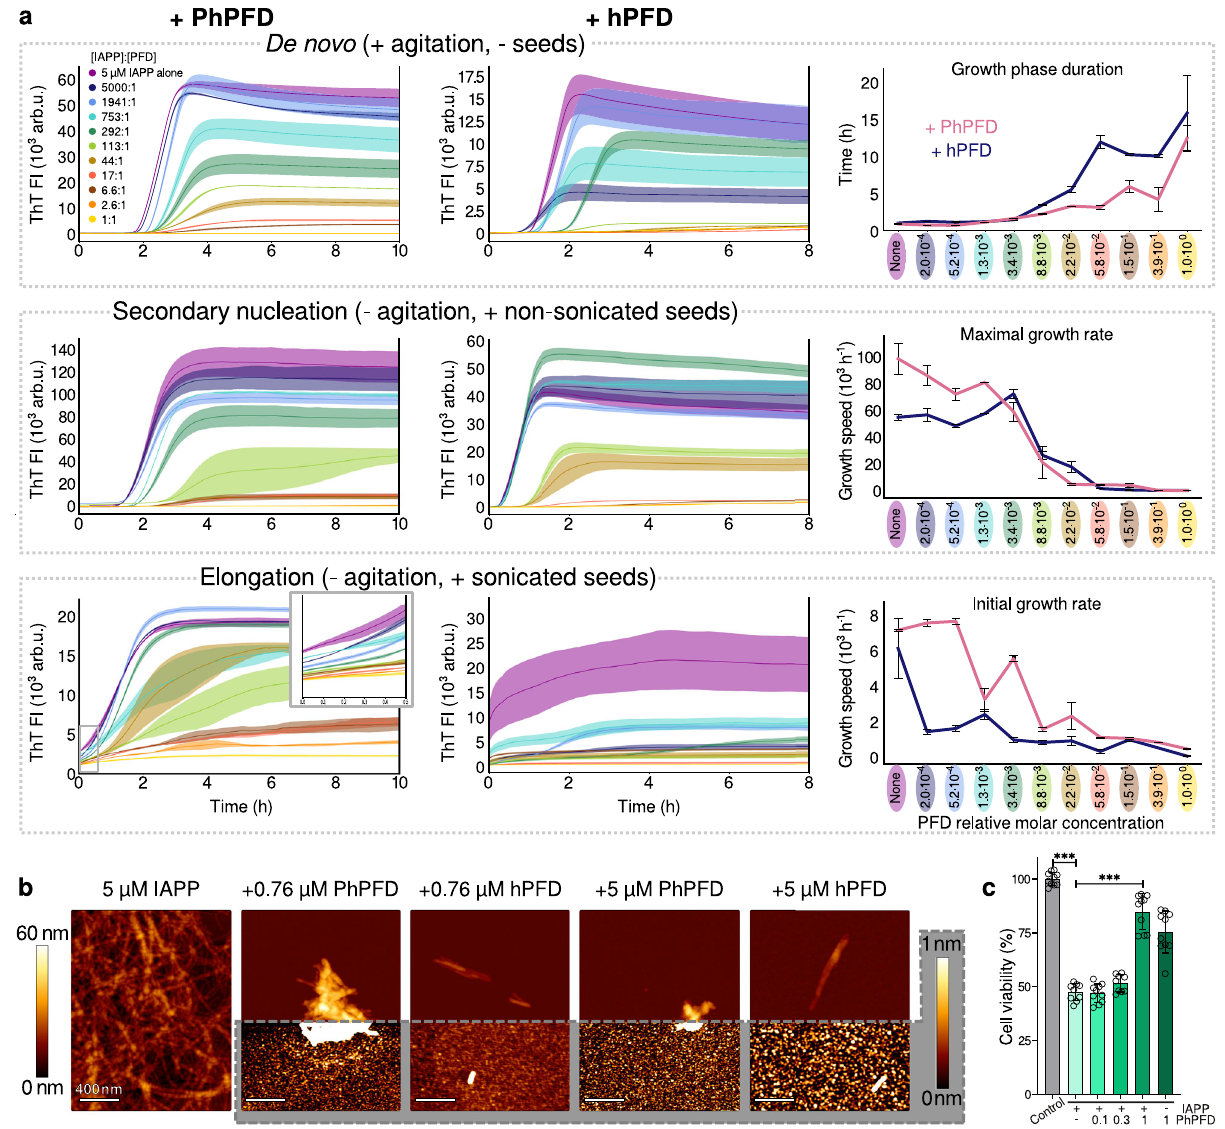
Fig. 1 Inhibition of IAPP aggregation by prefoldin. a IAPP (5 µ M) aggregation kinetics in absence and presence of PhPFD (left column) and hPFD (middle column) with [PFD]:[IAPP] molar ratios ranging from 1:5000 to 1:1, followed by ThT fl uorescence intensity (FI). Top row: de novo aggregation assay, starting from monomeric IAPP only, in presence of agitation. Middle row: secondary nucleation assay, starting from a mixture of monomeric IAPP and non- sonicated preformed IAPP fi brils (seeds), without agitation. Bottom row: elongation assay, showing non-agitated aggregation of monomeric IAPP in presence of shorter sonicated seeds, where the initial linear parts of the curves (inset) are re fl ecting pure elongation of fi bril seeds. The right column shows extracted kinetic parameters: growth phase duration, maximal growth rate, and initial growth rate. Further kinetic analysis is presented in Supplementary Fig. 1a. Every curve represents a mean of n = 3 replicates with the error shadows illustrating SD; the kinetic parameters are shown as mean ± SD. b AFM images of the samples at the end of the aggregation assays in section a (top row). Scale bar corresponds to 400 nm. In order to visualize objects decidedly differing in height, two color code scales were used: the gradient from dark brown to white represents either 0 – 60 nm height, or 0 – 1 nm (highlighted in gray). The full AFM overview is presented in Supplementary Fig. 2, including the control sample containing PFD alone and illustrating that the carpet-like coverage of the surface with small roundish particles at increased PFD concentration is the appearance of PFD itself. c PhPFD reduces the IAPP-induced negative impact on cell viability of RIN-m5F cells. After incubation of RIN-m5F cells with 1 µ M IAPP w/o or with several concentrations of PhPFD (0.1, 0.3, 1 µ M), an MTT cell viability test was conducted. Data is represented as mean ± SD (out of n = 2 independent experiments with four to fi ve technical replicates), one-way ANOVA with Tuckey post hoc analysis, *** p ≤ short, pre-formed IAPP fi brils to offer a high number of fi bril (see Arosio et al. for an overview of potential target species for ends (Fig. 1a, bottom row). Under these conditions, the very fi rst inhibition of speci fi c steps of amyloid fi bril formation 43 ). Fibril elongation, i.e., the binding of monomers to fi bril ends phase of linear growth re fl ects the pure elongation process, while and their conformational conversion into the fi brils ’ cross- β the subsequent exponential increase indicates that secondary structure, is dominating the aggregation kinetics when a high nucleation starts to contribute. Addition of PFD results in a concentration of fi bril ends is present 44 . For observation of PFD ’ s distinct decrease of the initial growth rate, demonstrating that effect on elongation of IAPP fi brils, we therefore added sonicated, PFD interferes also with fi bril elongation. Substoichiometric PFD